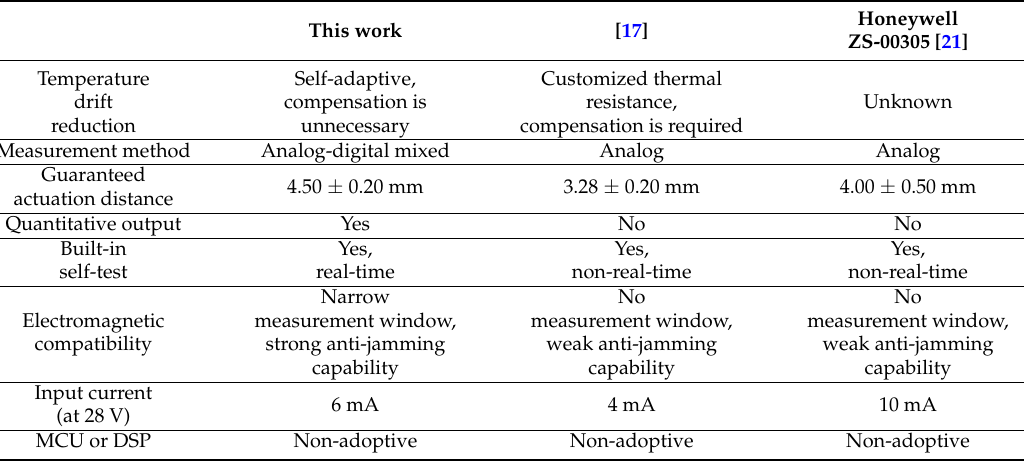
Table 1. Comparison of this work with related